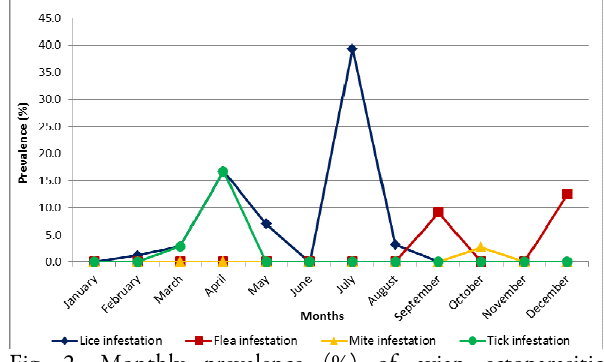
Fig. 2. Monthly prevalence (%) of avian ectoparasitic infestations in the major Veterinary Hospitals in Osun State from